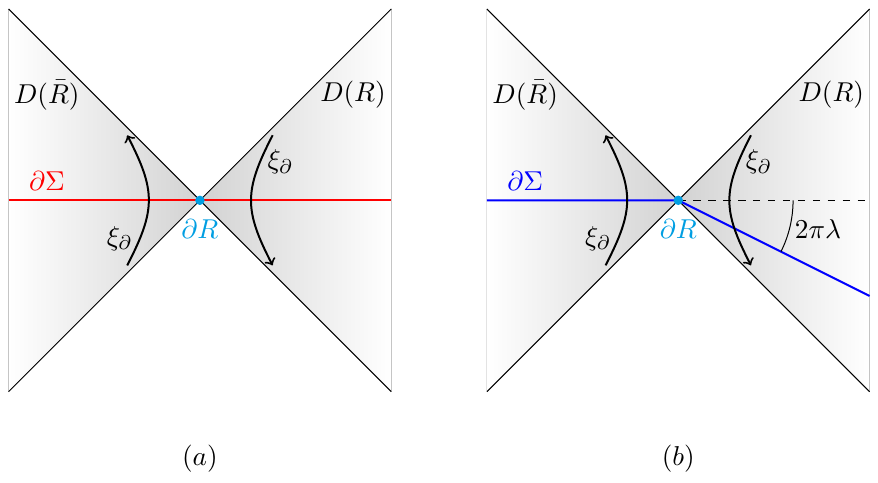
Figure 1 . The conformal boundary of our spacetime, showing the domains of dependence D ( R ) of R and D ( ¯ R ) of ¯ R . The boundary metric has a Killing field ξ ∂ that acts as a boost near ∂R . (a) The boundary ∂ Σ of a smooth bulk Cauchy surface Σ in the original spacetime. The surface ∂ Σ and all boundary observables on that surface are preserved by the flow generated by A HRT R . (b) The kink transformation with parameter λ moves the part of ∂ Σ in D ( R ) by sliding it toward the past along orbits of ξ ∂ through a Killing parameter 2 πλ/κ . Near ∂R this acts as a past-directed boost with rapidity 2 πλ